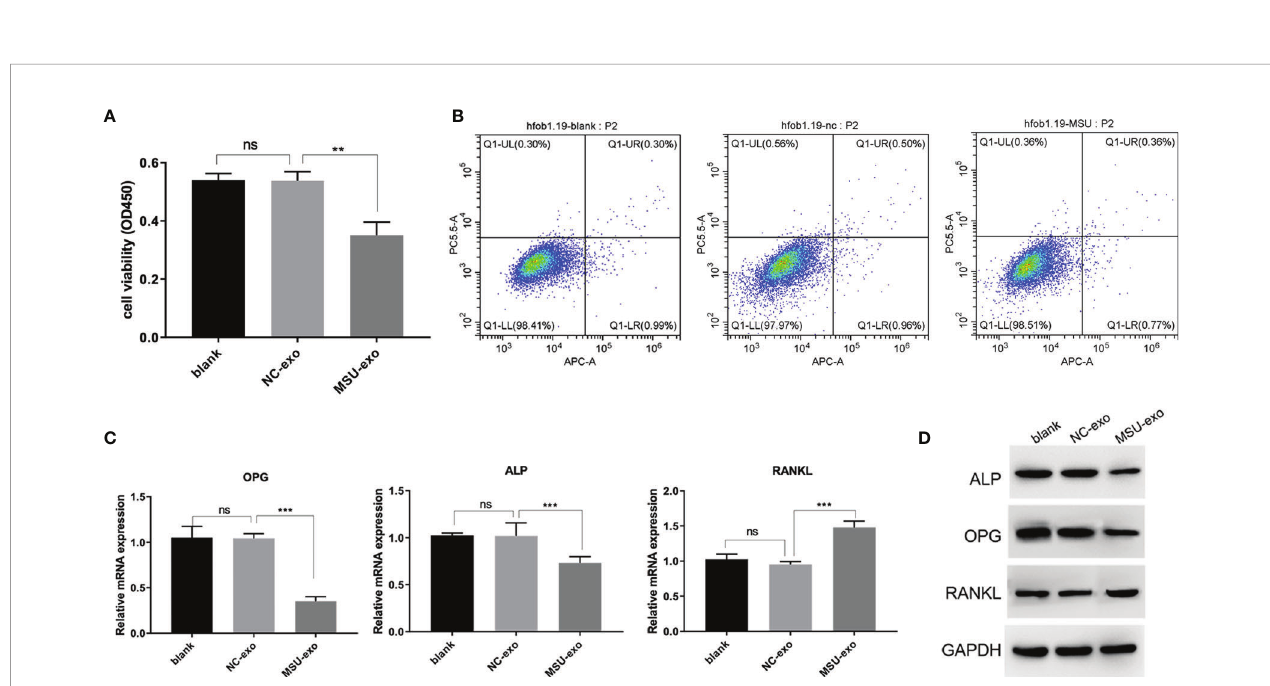
FIGURE 3 | The effects of MSU-induced neutrophil-derived exosomes on hFOB. (A) CCK-8 assay is used to detect the cell viability. (B) Apoptosis is detected by fl ow cytometry. (C) QPCR was used to assess miRNA expression levels of ALP, OPG and RANKL. (D) Protein expression levels of ALP, OPG and RANKL in hFOB cultures were determined via western blot analysis. P<0.01**, P<0.001 ***determined by the t-test. ns, no signi fi